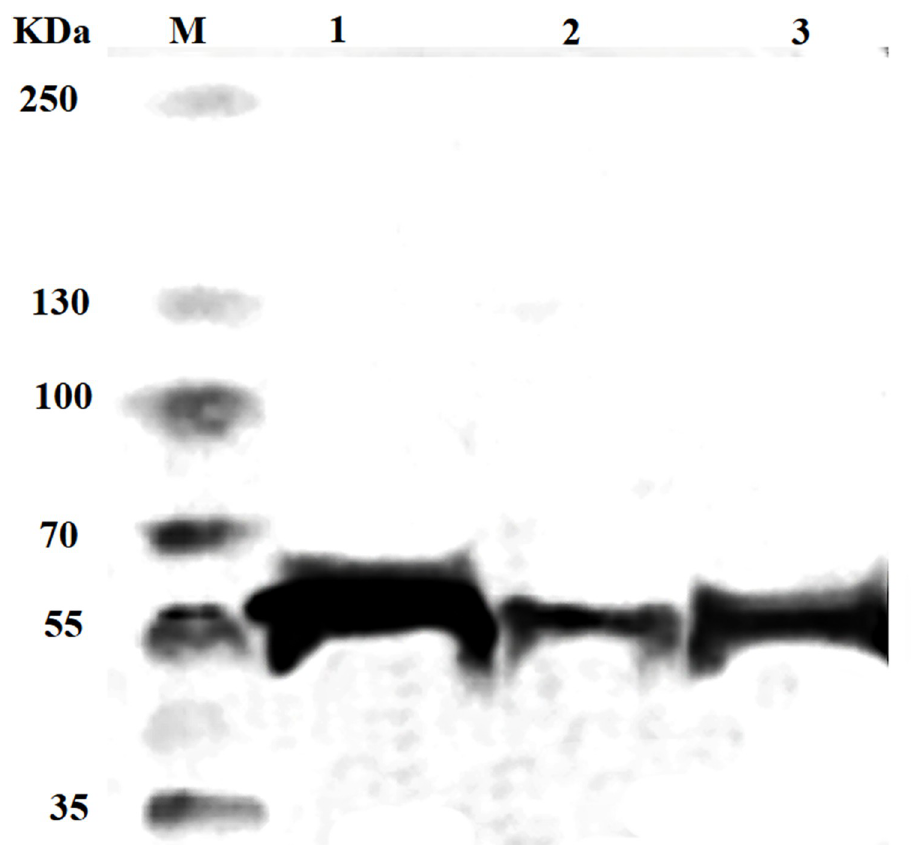
Fig 1. Western blot analysis of purified Fc fusion proteins by probing with goat anti-human IgG (Fc specific)- peroxidase antibody under reducing conditions. M: Protein ladder, Lane 1: anti- PD-1, Lane 2: CD80-Fc, and Lane 3: